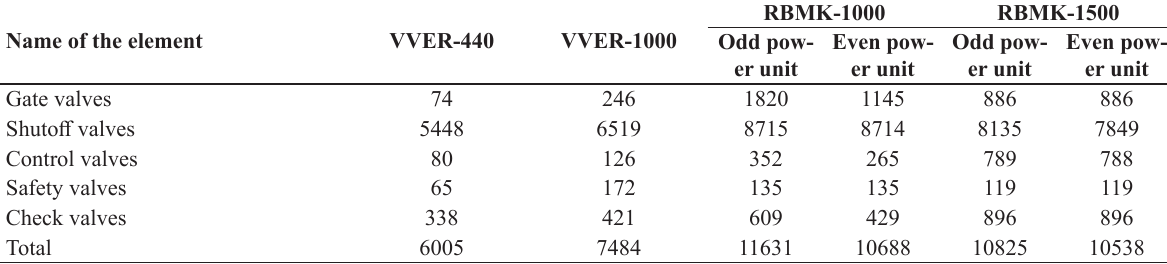
Table 1. Quantities of fittings installed on power units of NPPs with VVER-440, VVER-1000, RBMK-1000 and RBMK-1500